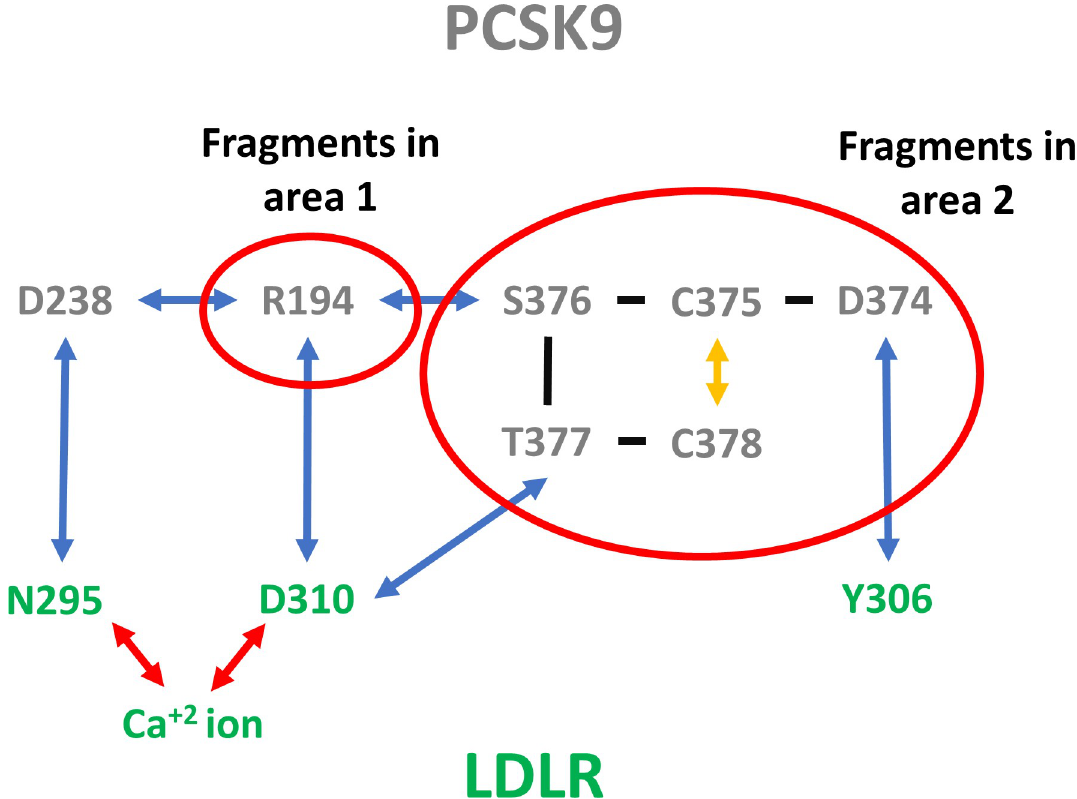
Fig 4. The network of charge delocalization, as observed from VDW overlap. LDLR residues are label with green font. The PCSK9 residues are labeled with grey font. Red arrows specify Ca +2 ion-LDLR bonds. Blue arrows illustrate hydrogen bonds. The yellow arrow marks a disulfide bond. Black dashes indicate sequential amino acids. The complete lists of residues were analyzed with a GAMESS/ RESP calculation to compute optimized partial charges derived using the RESP algorithm to best fit the electrostatic potentials from electron densities produced by GAMESS (S1 Table). Using SACP simulations, we identified fragments in area 1 and area 2 that could break this network of charge